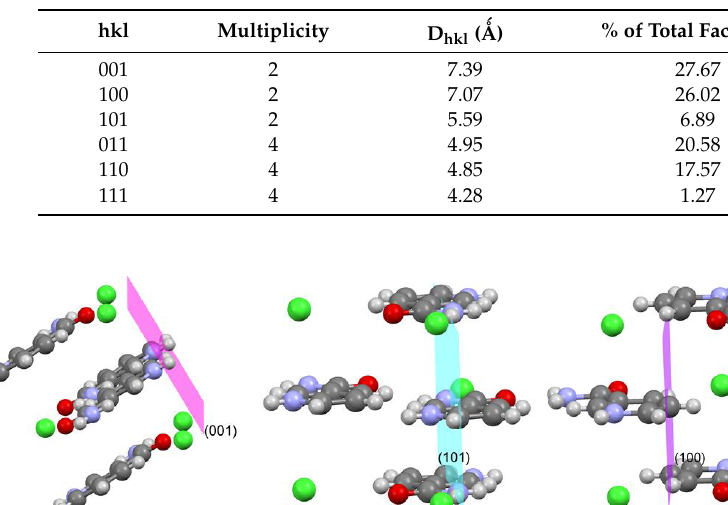
Figure 4. (a) BFDH predicted morphology (morphological importance (MI) faces are shown together with their Miller indices) (b) Experimental crystal morphology (SEM image). Table 3. Morphology predictions for the monoclinic structure of (C 6 H 7 N 2 O) + · Cl − by means of Bravais–Friedel–Donnay–Harker (BFDH).